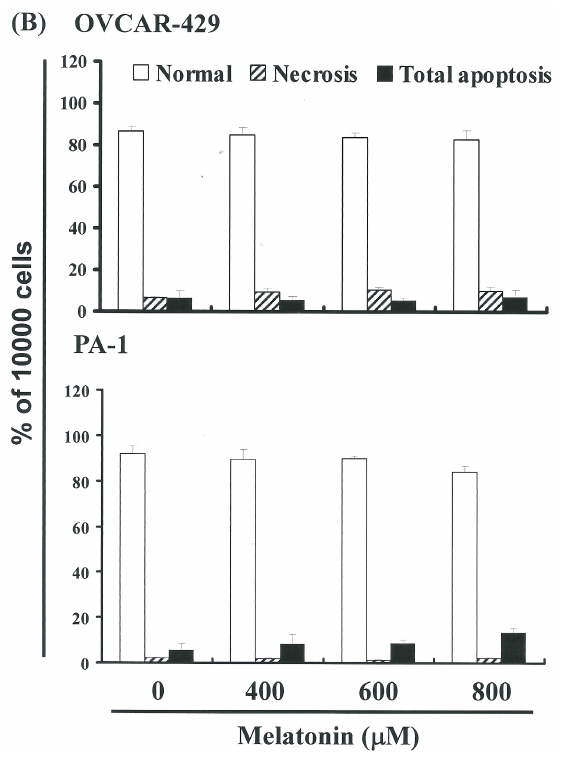
Figure 2. ( A ) the influence of melatonin on apoptosis and necrosis in OVCAR-429 and PA-1 cell lines;